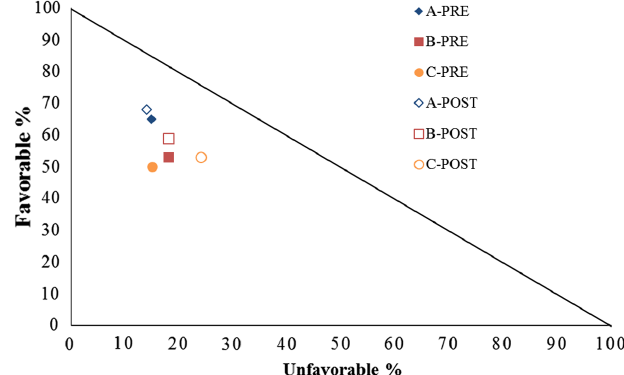
FIG. 1. FAV/UNFAV prepost instruction plot by instructor in our study.